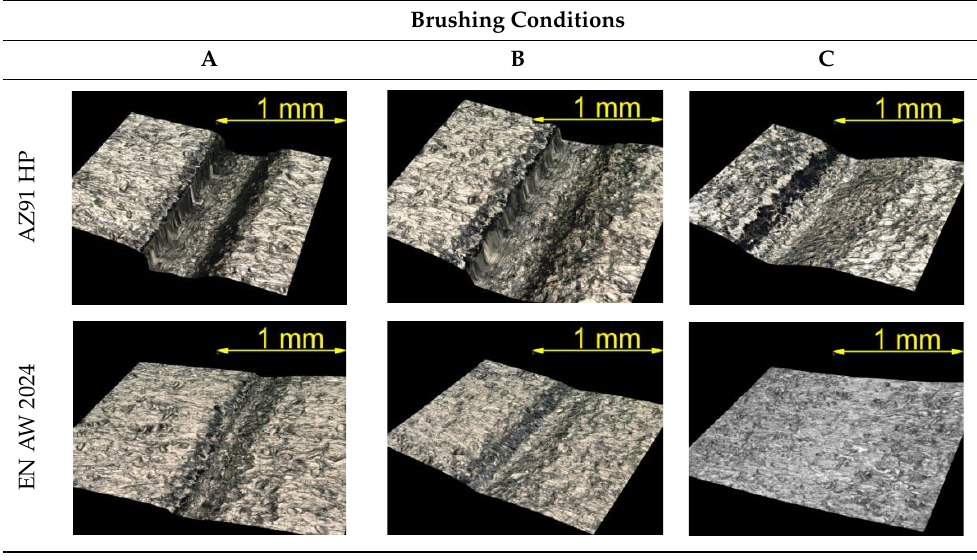
Table 5. View of defects after the brushing process (for a defect generator load of 15 N).